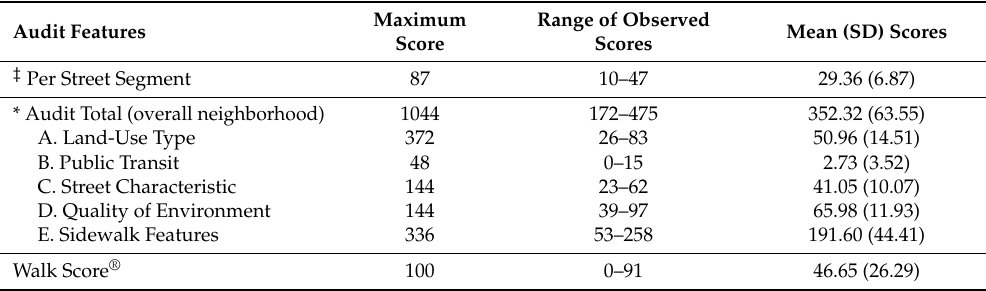
Table 1. Results of Google Street View-based audits utilizing the Active Neighborhood Checklist and new scoring